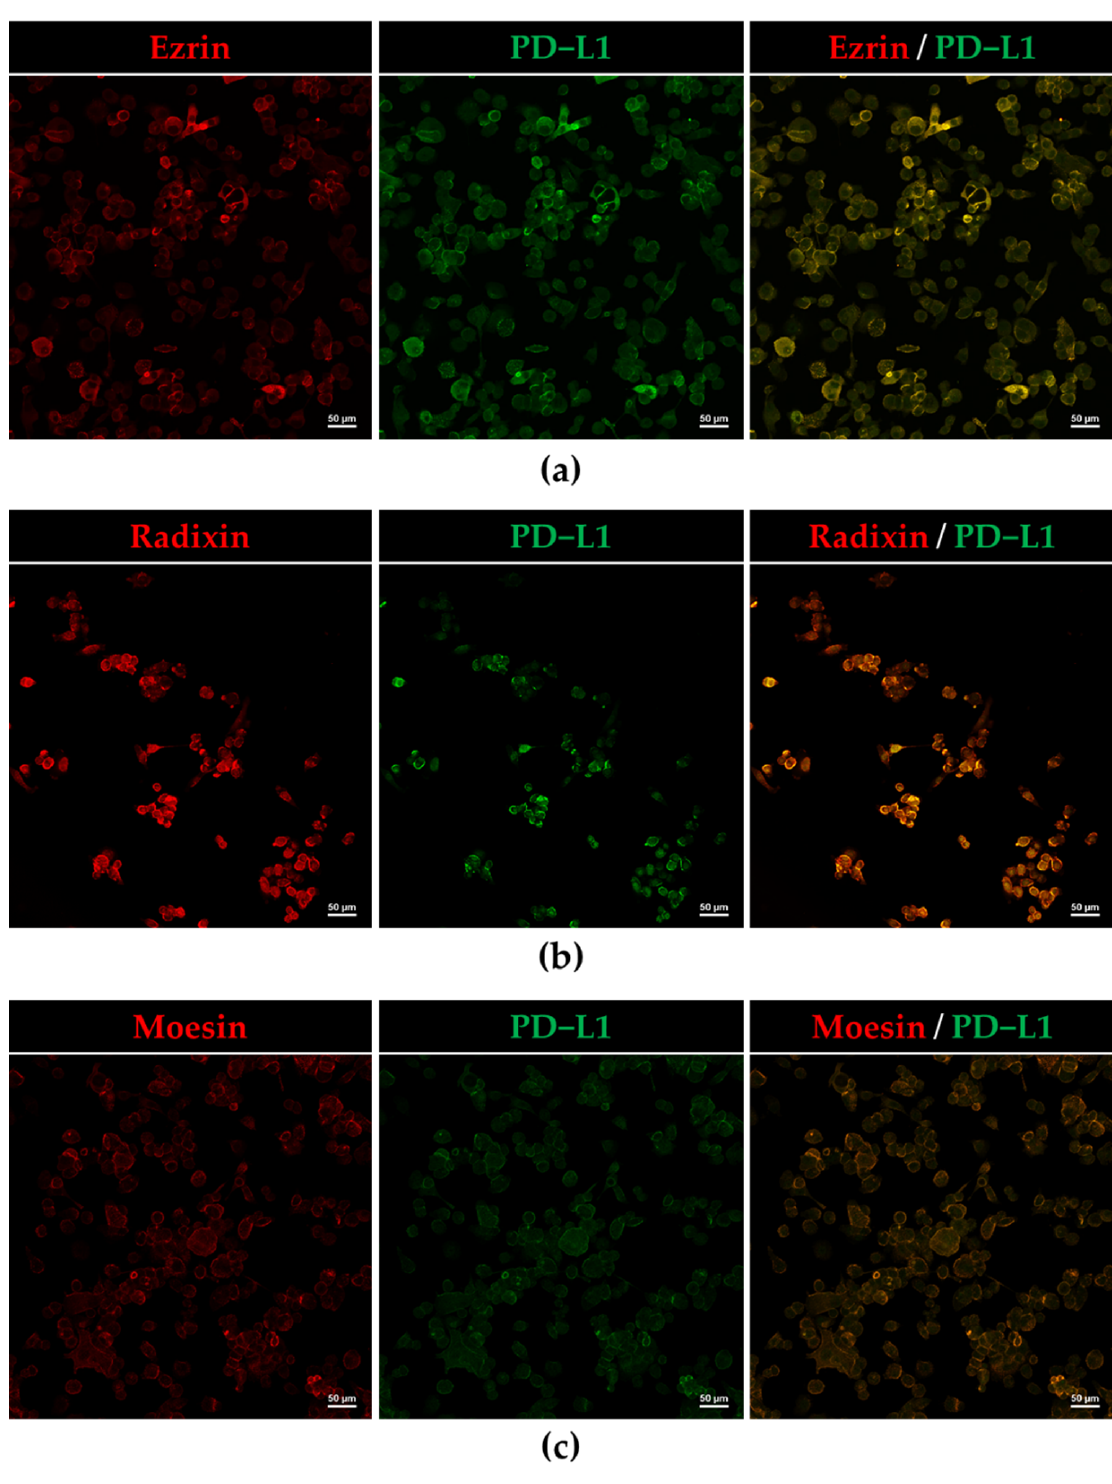
Figure 3. Programmed death ligand-1 (PD-L1) was colocalized with ezrin, radixin, and moesin in the plasma membrane of HEC-151 cells. Colocalization of ( a ) ezrin, ( b ) radixin, and ( c ) moesin (Alexa Fluor 594) with PD-L1 (Alexa Fluor 488) in the plasma membrane as analyzed by confocal laser scanning microscopy. Scale bars: 50 µm.